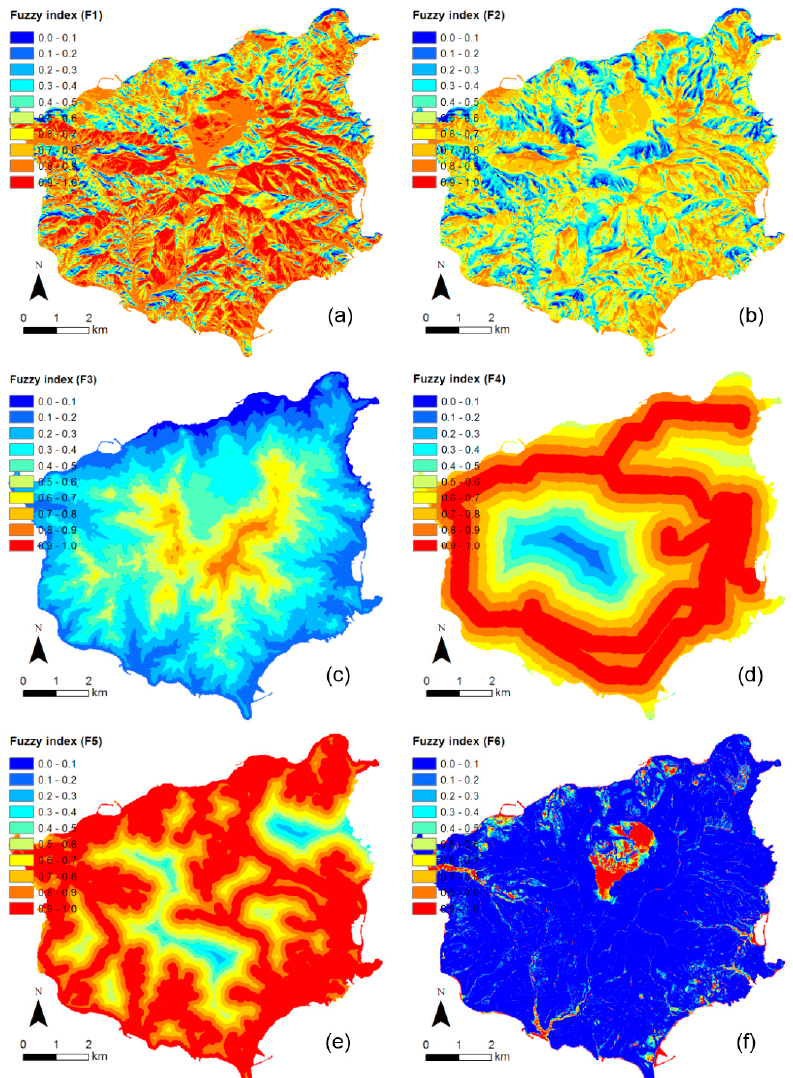
Figure 4. Fuzzy scaled inputs for each factor variable: ( a ) solar irradiation; ( b ) equivalent sunshine hours; ( c ) average temperature in summer; ( d ) 3D path distance from nearest transmission line; ( e ) 3D path distance from nearest road; and ( f ) slope.